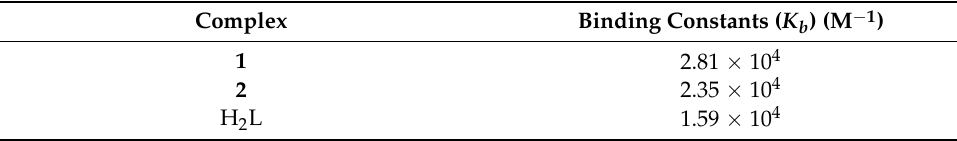
Table 3. DNA-binding parameters for 1 , 2 , and H 2